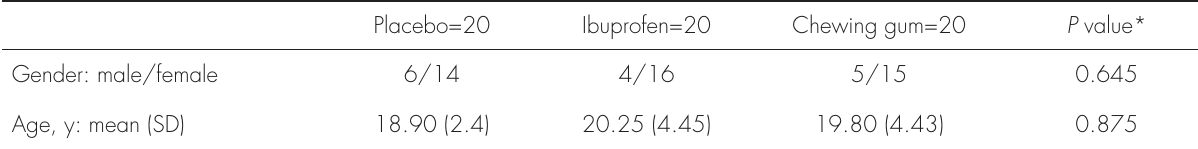
Table I. Baseline characteristics of patients in each treatment